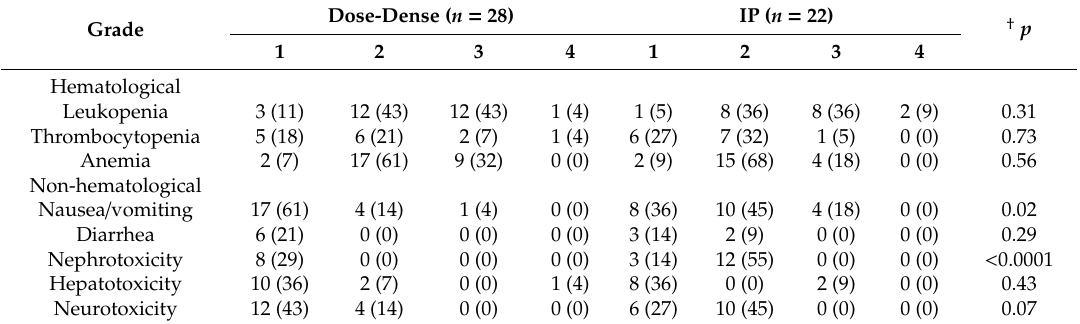
Table 4. Toxicity profile of women receiving intraperitoneal or dose-dense chemotherapy ( n = 50).